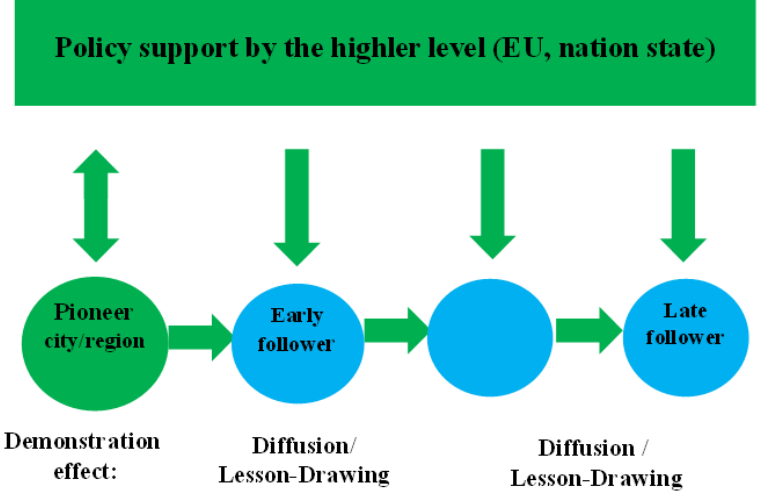
Figure 7. Horizontal dynamics induced by the higher policy